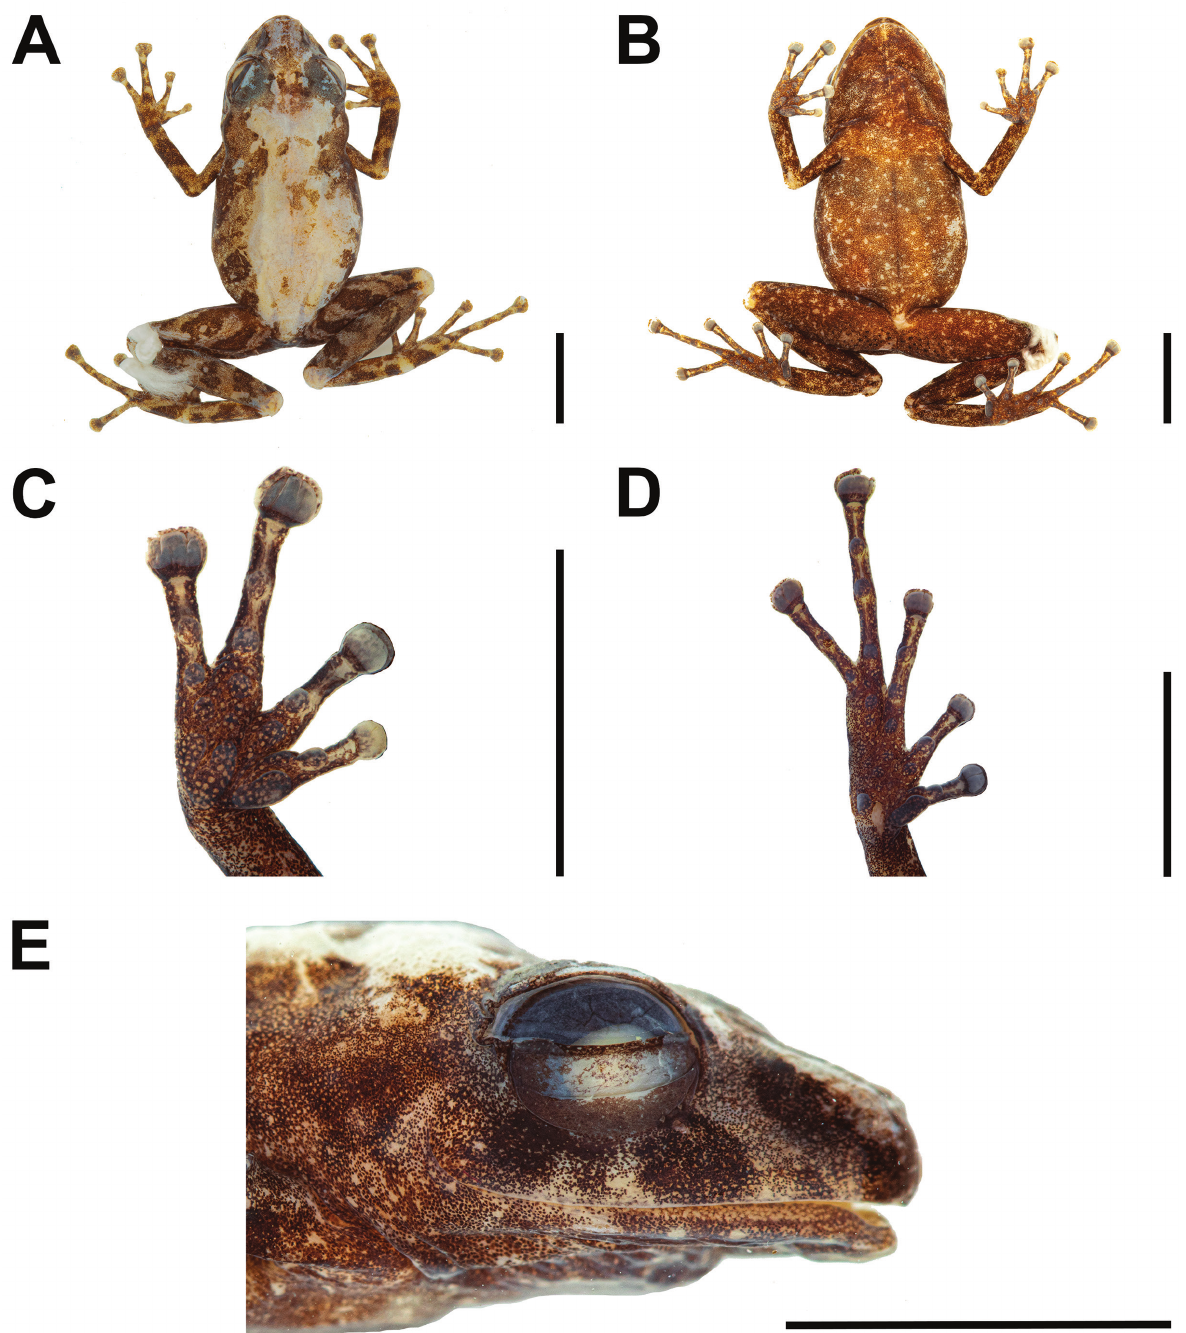
Figure 2. Holotype of Pristimantis sira sp. nov. in preservative (CORBIDI 14430). ( A ) dorsal view of the body; ( B ) ventral view of the body; ( C ) ventral view of the right hand; ( D ) ventral view of the right foot; ( E ) lateral view of the head. Photographs by Luis A. García–Ayachi. Scale bar = 5